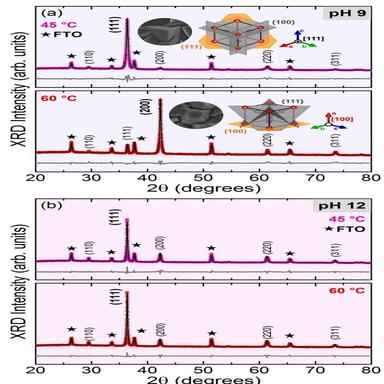
Refined XRD profiles for the Cu2O thin films electrodeposited at different temperatures on FTO at (a) pH 9 and (b) pH 12. Each figure shows the observed pattern (dotted line), Rietveld's calculated pattern (solid line), and the goodness of fit or residual pattern (at the bottom). The diffraction peaks associated with the FTO substrate are indicated by a star (★). The inset figures in (a) show the difference in the crystal shape corresponding to growth direction 〈111〉 (upper panel for 45 ◦C) and 〈100〉 (upper